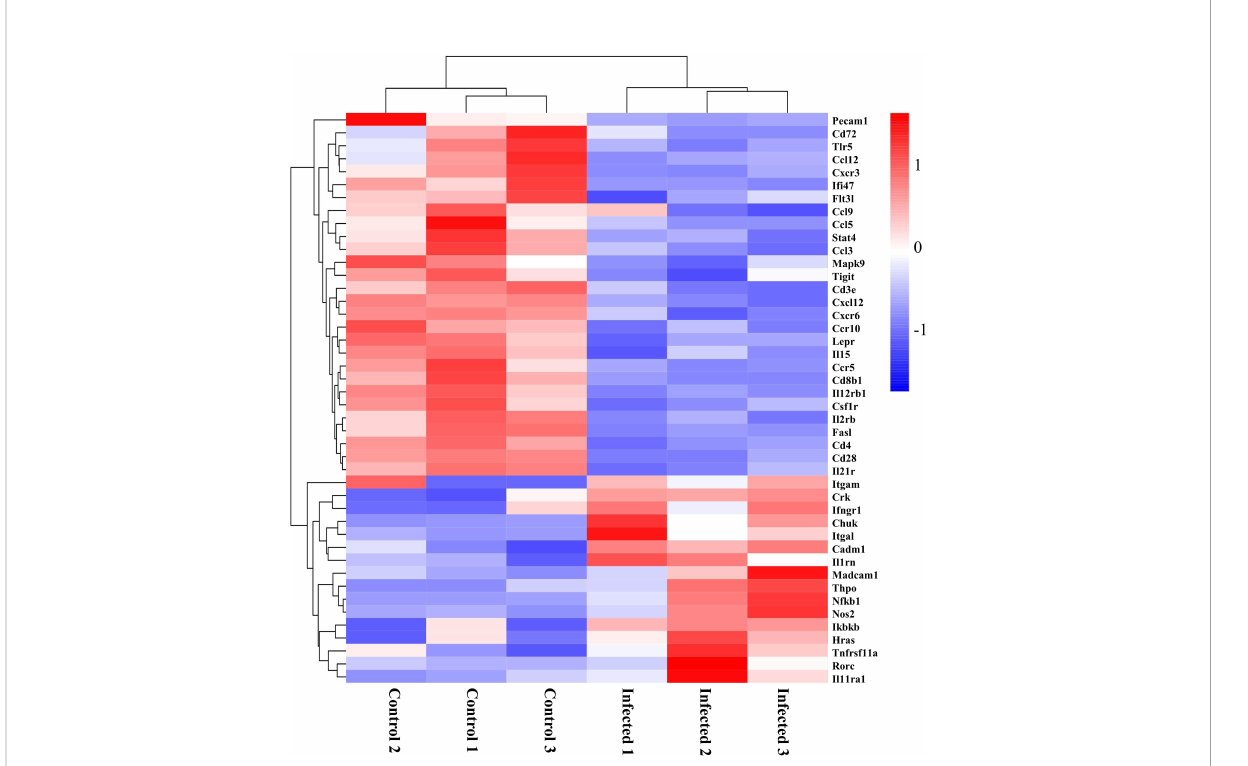
FIGURE 6 Clustering heatmap of differential genes associated with immunity in the colon post the protoscoleces of Echinococcus granulosus infection. Red color means the upregulated mRNAs, and blue color means the downregulated